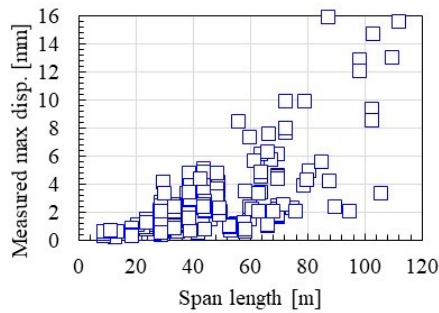
Figure 14. Relationship between the span length and the maximum measured bridge displacement